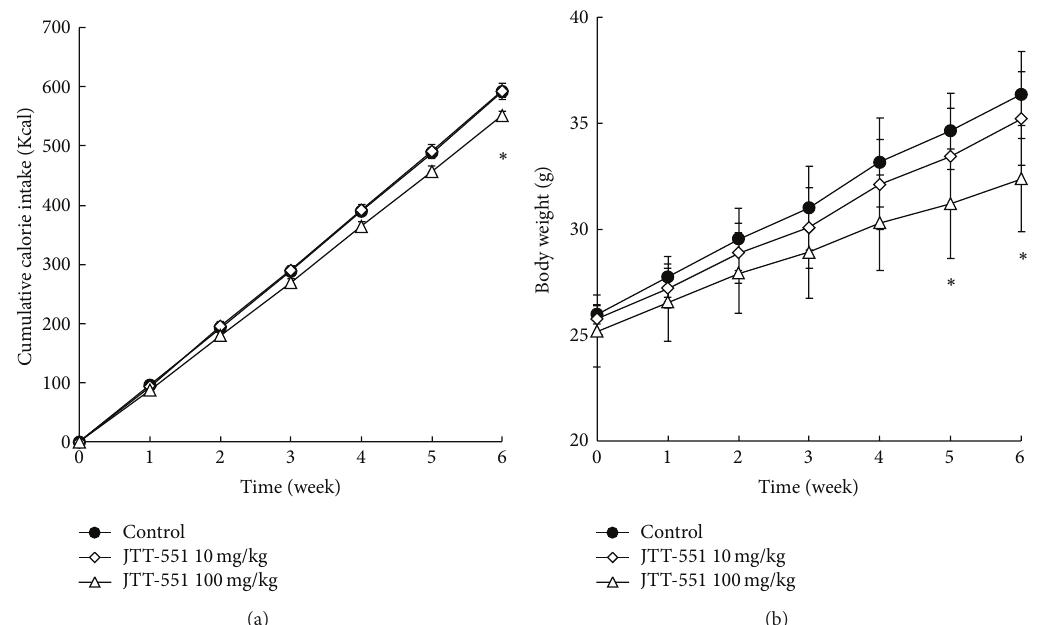
Figure 3: Effect of JTT-551 on cumulative calorie intake and body weight in DIO mice. DIO mice were given 10 or 100mg/kg food containing JTT-551 for six weeks. Data represent mean ± SD ( 𝑛 = 5 ). ∗ 𝑃 < 0.05 : significantly different from the control by Dunnett’s test (two-tailed).